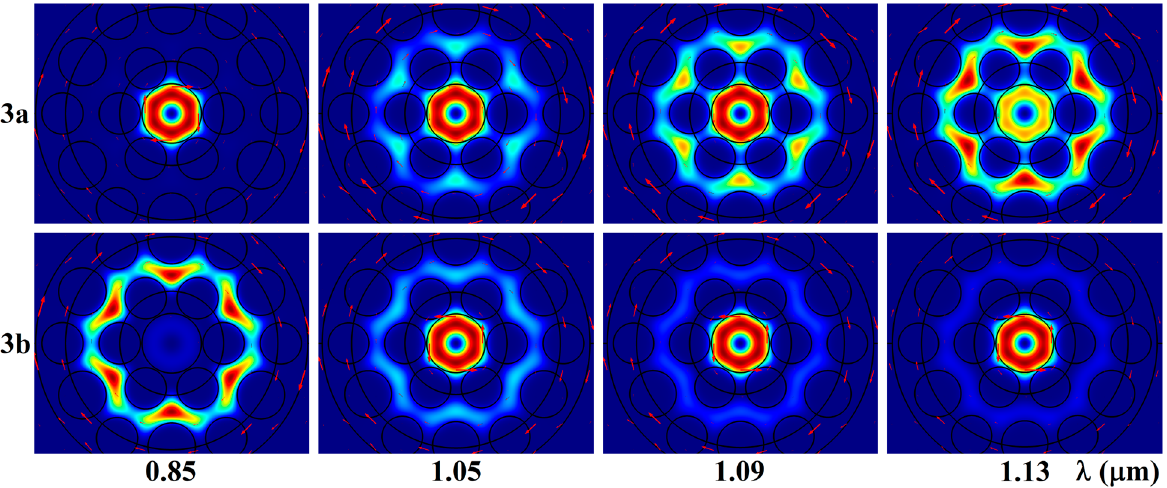
Figure 4. Spatial intensity distributions of Modes 3a and 3b in the straight MOF-18 for wavelengths of 0.85 µm, 1.05 µm, 1.09 µm, and 1.13 µm.